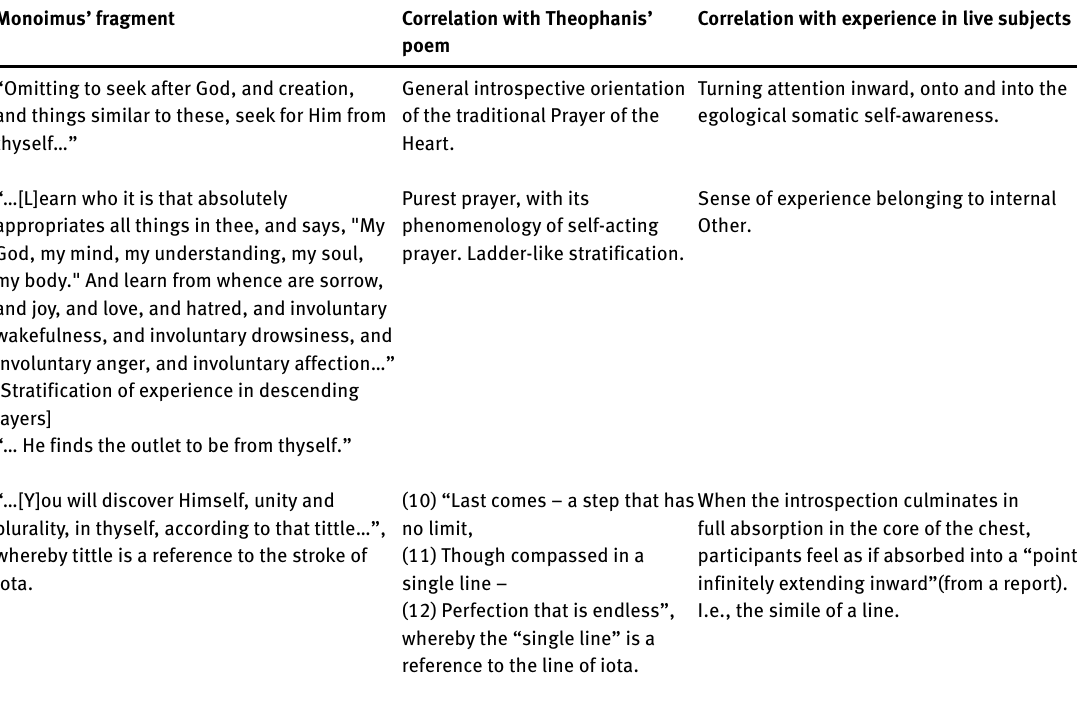
Table 3. References to Introspective Experience in Monoimus’ Fragment in comparison with Theophanis’ poem Monoimus’ fragment Correlation with Theophanis’ thyself…”